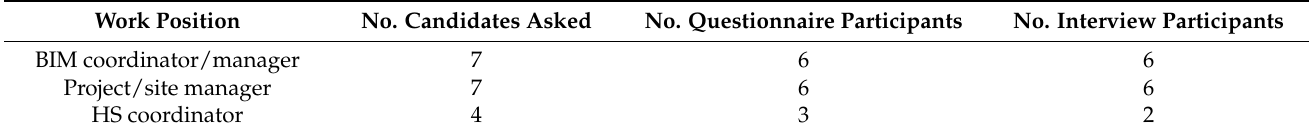
Table 2. Number of selected professionals based on criteria presented in Table